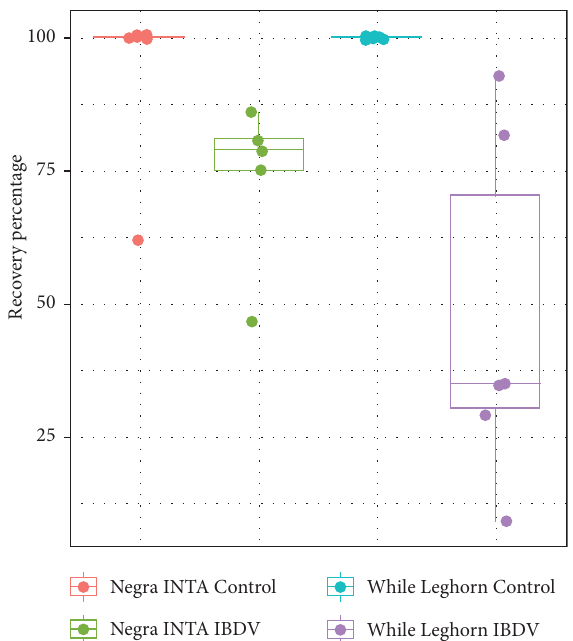
Figure 3: Recovery evaluation of bursal follicles of infected chickens. Bursae collected at 28dpi were fxed and PAS stained. Te number of follicles with and without PAS-positive membranous structures was counted in each sample. Recovery index (RI) was calculated using the following formula: RI � total number of PAS- negative follicles/total number of PAS-positive follicles. Results are presented as the mean of the RI of each